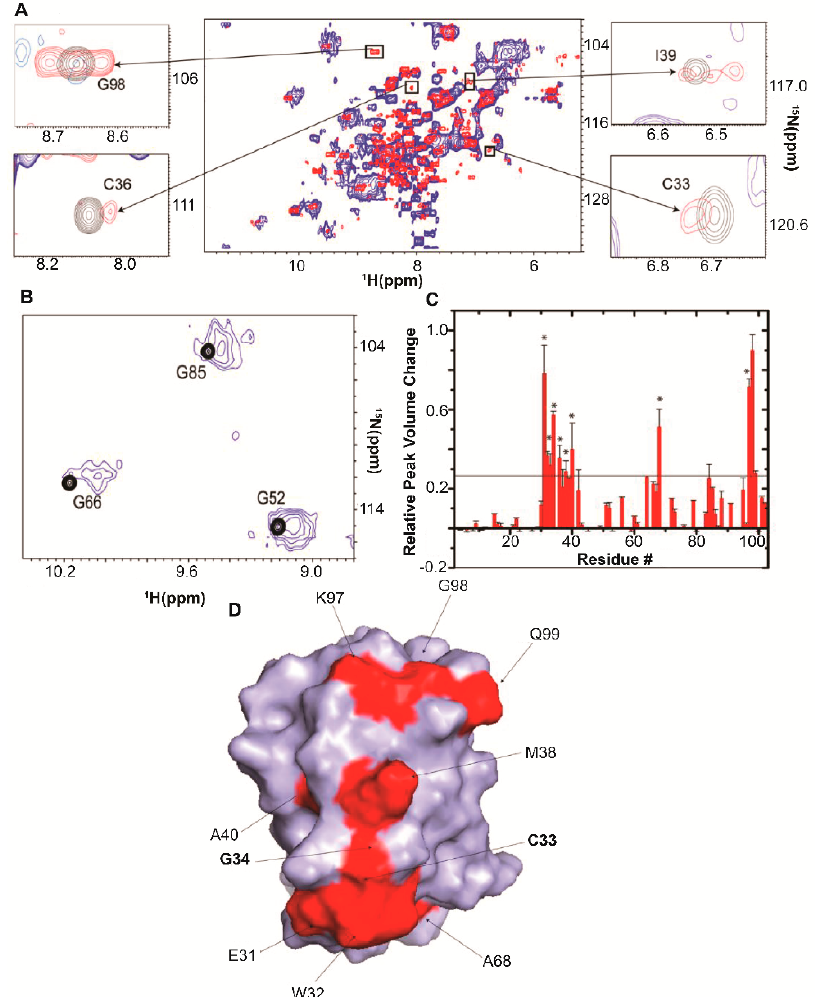
Figure 6. Quinary interactions of Trx in E. coli . ( A ) Overlay of the in-cell 1 H- 15 N CRINEPT–HMQC–TROSY spectra of [ U - 2 H, 15 N] Trx (blue) and that of the cellular lysate (red). The insets show overlays of the boxed regions of the in-cell spectrum (blue) and the corresponding regions of the 1 H- 15 N CRINEPT–HMQC–TROSY spectrum of lysate (red) and the 1 H- 15 N HSQC spectrum of purified Trx in 10 mM potassium phosphate buffer (pH 6.5) (black). The intensities of the C33, C36, I39, and G98 peaks, residues involved in quinary interactions, are broadened in-cell. ( B ) Overlay of the 1 H- 15 N CRINEPT–HMQC–TROSY spectrum of [ U - 2 H, 15 N] Trx in E. coli (blue) with crosspeaks from the 1 H- 15 N HSQC spectrum of purified [ U - 2 H, 15 N] Trx in 10 mM potassium phosphate buffer, pH 6.5 (black). G52, G66, and G85 exhibit broad in-cell peaks characteristic of multiple conformations of Trx in fast exchange on the NMR time scale, implying that the quinary interactions are inherently transient and dynamic. ( C ) Relative changes in in-cell 1 H- 15 N CRINEPT–HMQC–TROSY crosspeak intensities of [ U - 2 H, 15 N] Trx residues due to quinary interactions. The horizontal threshold differentiates residues whose NMR peaks undergo significant broadening. Residues annotated with asterisks are also affected in total RNA-bound Trx. ( D ) Residues involved in the quinary interactions (red) are mapped onto the molecular surface of Trx (PDB entry 1X0B); active site residues, C33 and G34, are in bold. The figure is adapted from Majumder et al . (2015) [14].